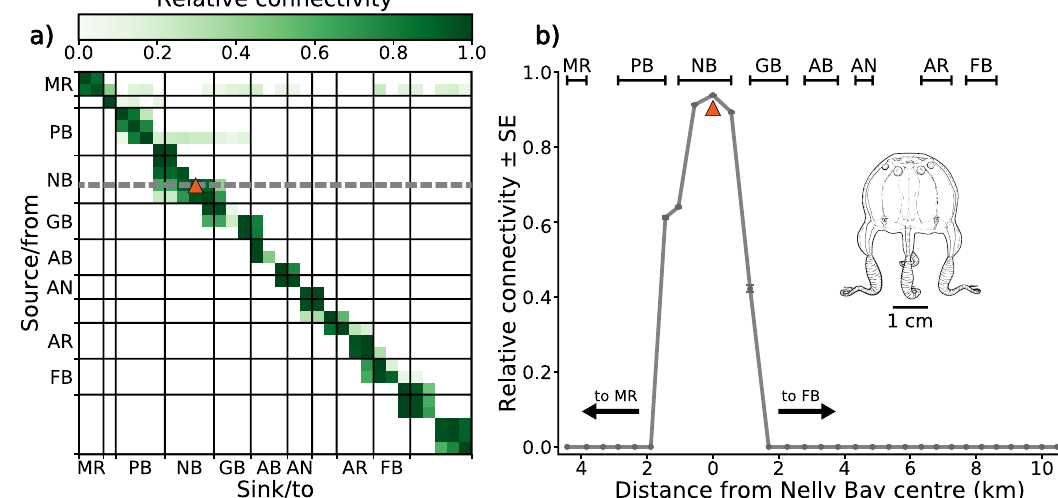
Figure 4. Population structure analysis (green colour scale). Substructure of the Copula sivickisi population at Magnetic Island. ( a ) The relative connectivity between source/from and sink/to detection zones over the entire 2017 medusae season. Each pixel represents one detection zone, and zones have been pooled by reefs/bays (solid lines in the matrix). The matrix shows the result from one of the five replicate model runs. ( b ) A cross section of the connectivity matrix, showing the average relative connectivity ± SE (n = 5) with distance from a focal detection zone in the centre of Nelly Bay. The cross section has been taken along the grey dashed line in pane ( a ), and the focal detection zone where source = sink is indicated by the orange triangles in panes ( a ) and ( b ). The geographic locations of the reefs/bays are shown in Fig. 1. The insert in pane ( b ) shows a male C. sivickisi